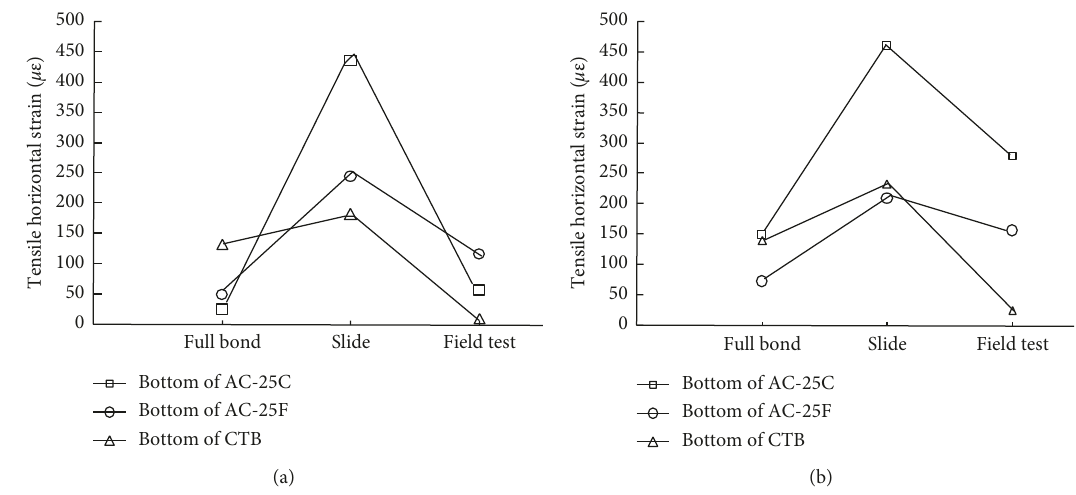
Figure 15: Effect of bonding condition on tensile horizontal strain. (a) Structure I. (b) Structure